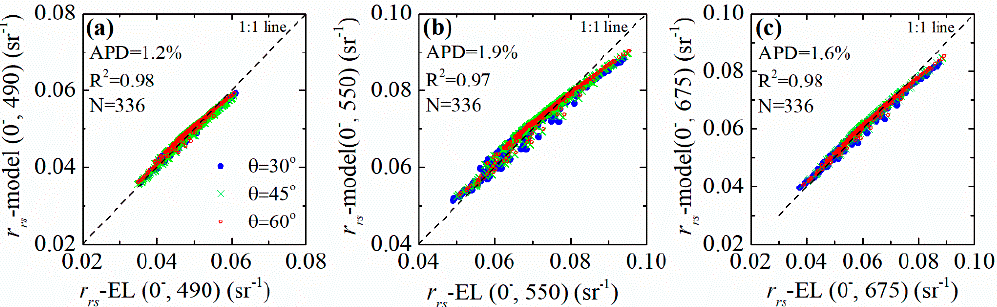
Figure 12. Validation of stratified r rs model using Ecolight-simulated data at ( a ) 490 nm, ( b ) 550 nm, and ( c ) 675 nm at different sun zenith angles ( θ = 30°, 45°, 60°), respectively.